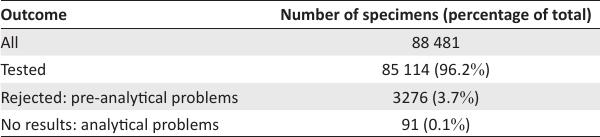
TABLE 1: Dried blood spot specimens received in 2014 at the Department of Virology laboratory at Inkosi Albert Luthuli Central Hospital, KwaZulu-Natal province, South Africa. Outcome